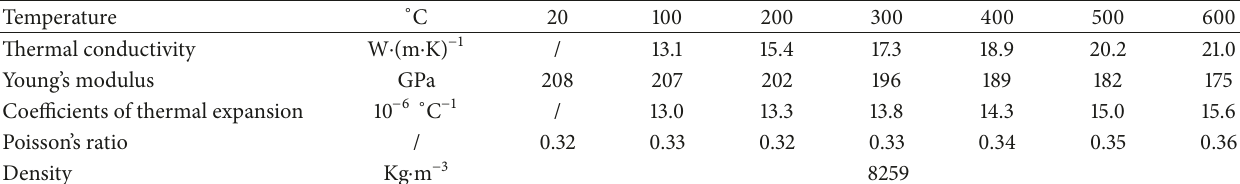
Table 2: Material properties of the gas turbine rotor (tie rods and turbine discs).